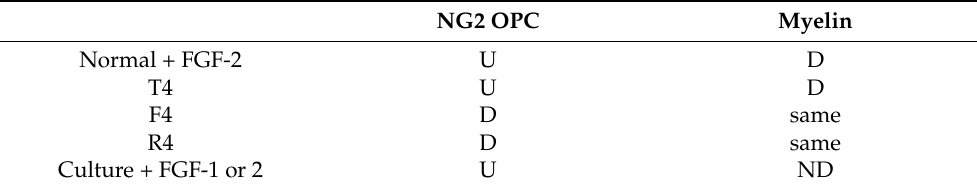
Table 2. Brief summary of different models of spinal cord injury treated with FGF-1 or 2. NG2 OPC Normal +